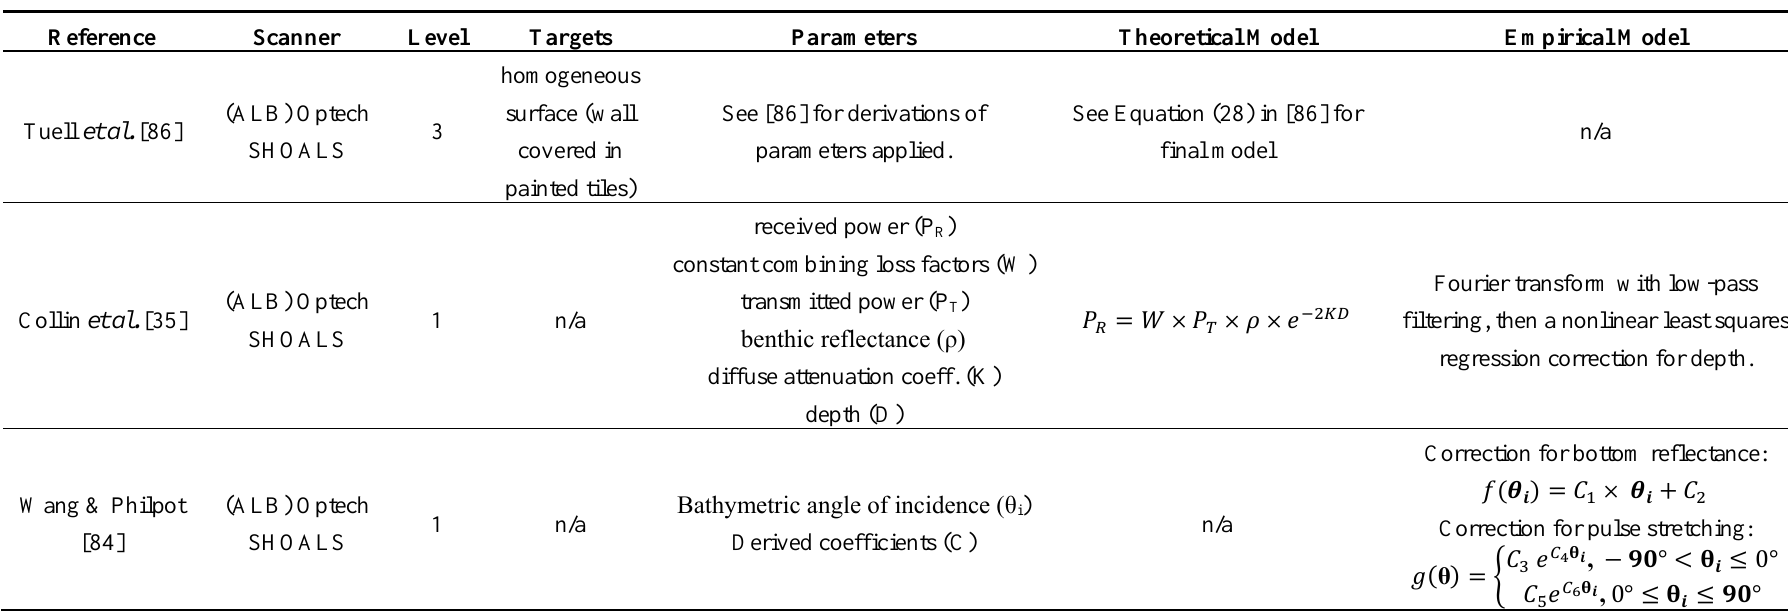
Table 5. Selected intensity correction and calibration methods exclusively for bathymetric